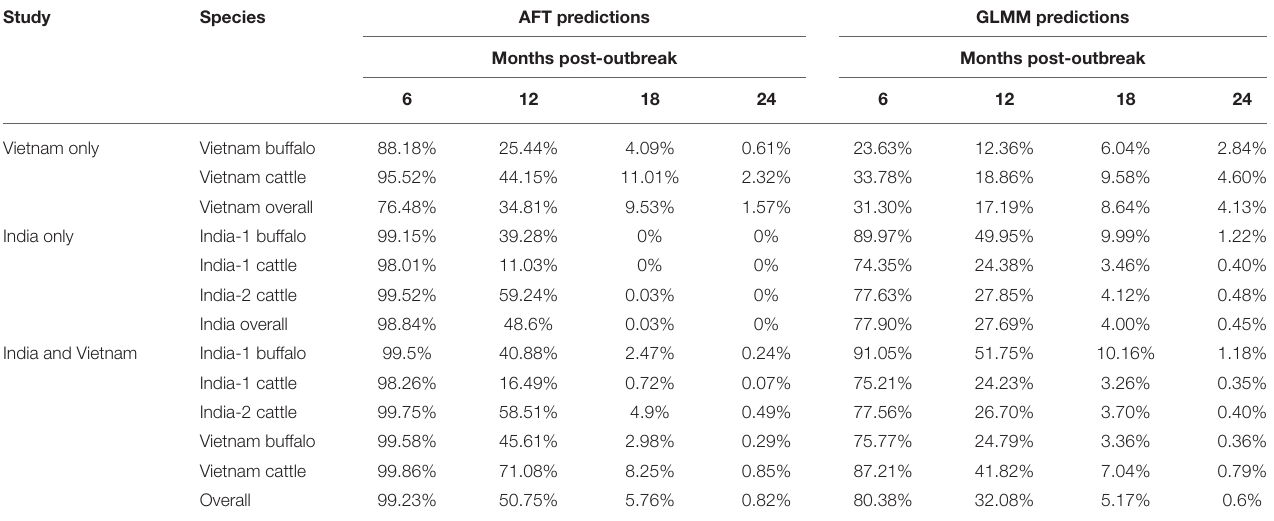
TABLE 2 | Predicted probability of persistent infection following an FMD outbreak.